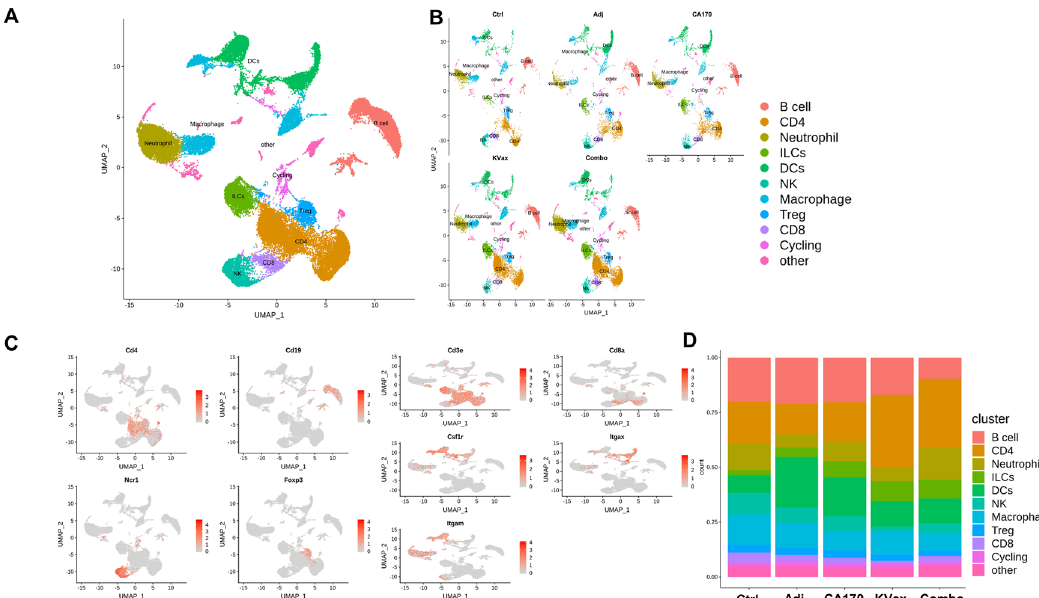
Fig. 5 Immune cell heterogeneity for the various lung cancer treatments in mice. Heterogeneity of total CD45 + TILs from lung tumors all together ( A ) and separately under fi ve different treatment conditions (Control, Adjuvant, CA170, KVAX vaccine and the combination of CA170 peptide plus KVAX vaccine) ( B ) in lung cancer shown by UMAP. C Feature plot shows representative genes for the different types of immune cells: CD4 + , CD8 + , B cells (Cd19), NK cells (Ncr1), Tregs (Foxp3), and Myeloid cell-speci fi c genes (Cd3e, Itgam, Itgax, Csf1r) across all clusters for the fi ve treatment conditions. D The bar plot shows the percentage of different immune cells under fi ve different treatment conditions